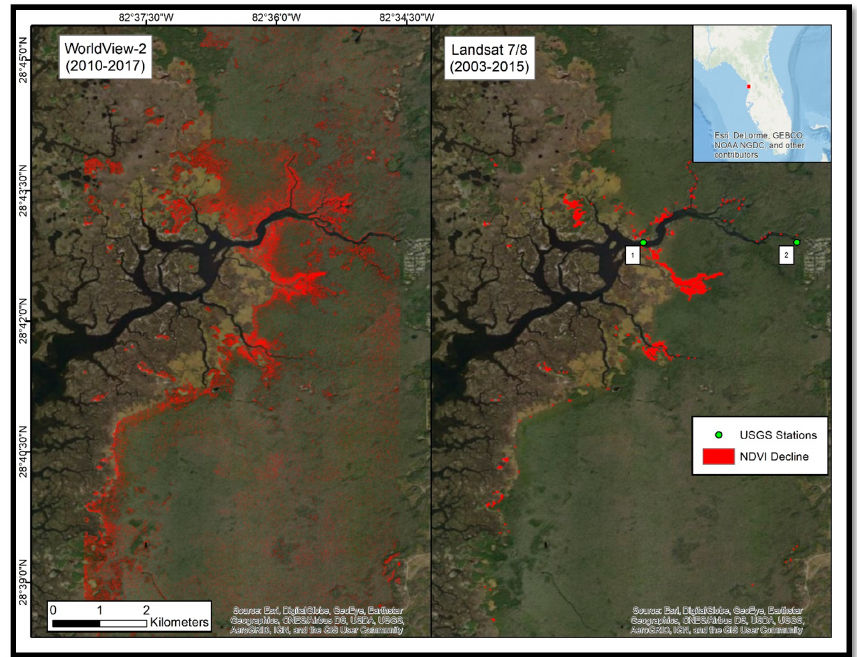
Figure 6. Decline in coastal forest NDVI (< − 0.05), shown in red, from WorldView-2 ( left ; 2010–2017) and Landsat ( right ; 2003–2015). United States Geologic Survey (USGS) river gauge station 1 and 2 sites are shown as green dots (background map source: ArcGIS ® basemaps). Table 2. Decline in NDVI (< − 0.05) for image pairs in km 2 (percent of study